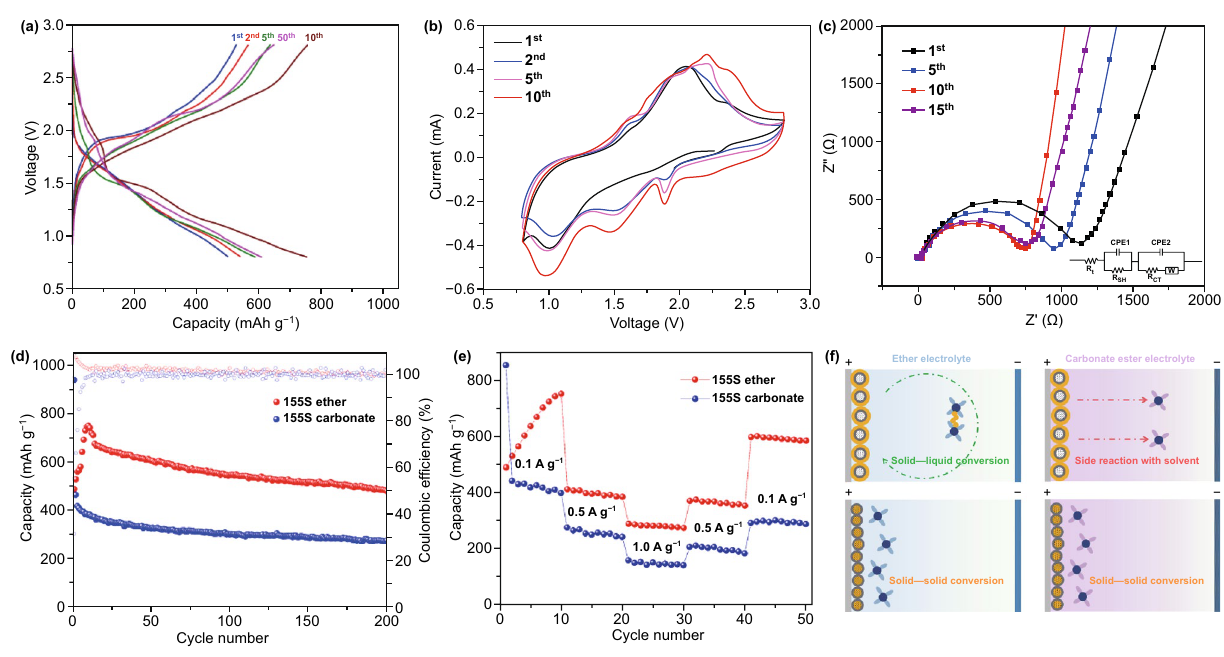
Fig. 4 a Discharge/charge curves of the 155S in ether electrolyte with NaNO 3 additive. b Corresponding CV curves of the 155S in ether elec‑ trolyte with NaNO 3 additive. c Corresponding EIS spectra of the 155S in ether electrolyte with NaNO 3 additive. d Cycling performances of the 155S at 0.1 A g −1 based on the mass of sulfur in ether and carbonate electrolyte. e Rate performance of the 155S at 0.1 A g −1 based on the mass of sulfur in ether and carbonate electrolyte. f Schematic illustrations of the mechanisms in ether and carbonate electrolyte for the sulfur on the surface (155S) and the sulfur in the pore of cathode host